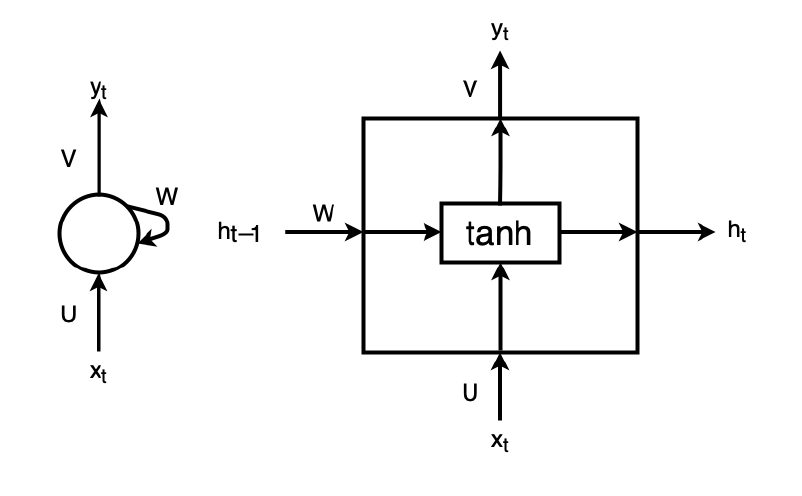
Figure 5. Recurrent neural